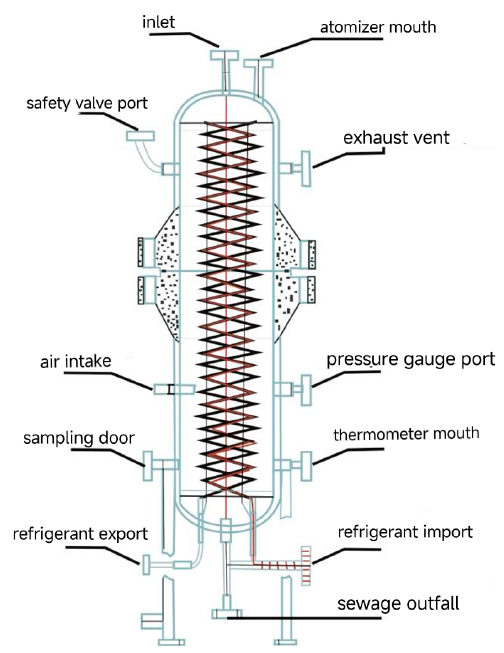
Figure 2. Schematic diagram of main structure of the reactor.